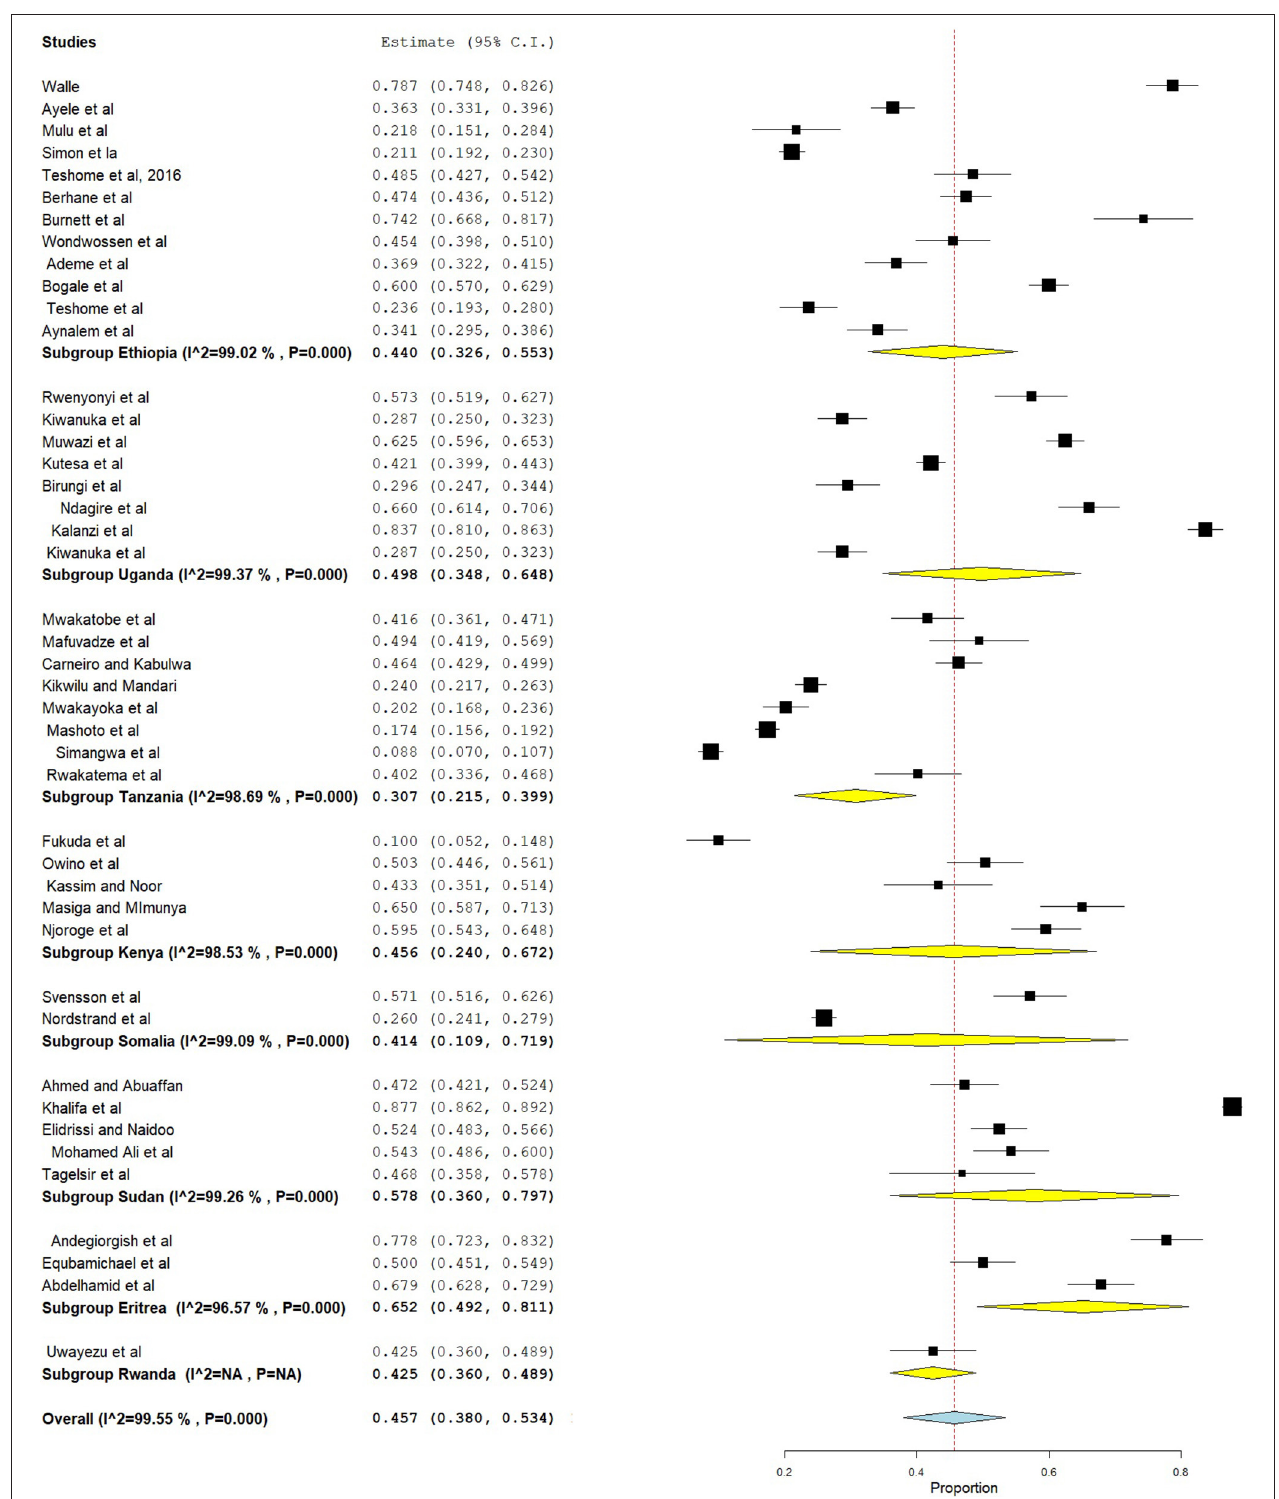
FIGURE 4 | Subgroup analysis on prevalence of dental caries based on country.